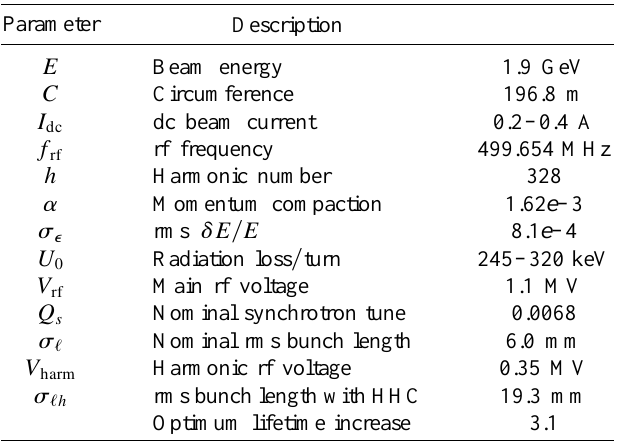
TABLE I. Nominal ALS